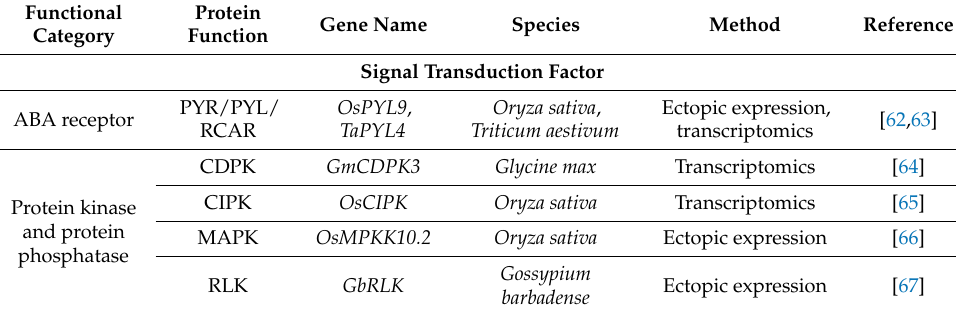
Table 1. Genes related to drought tolerance in crop